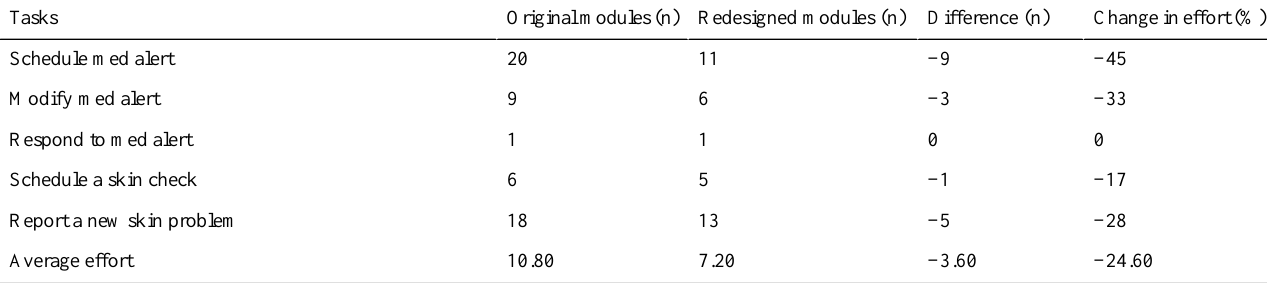
Table 3. User effort: minimum number of screen touches to complete a task.